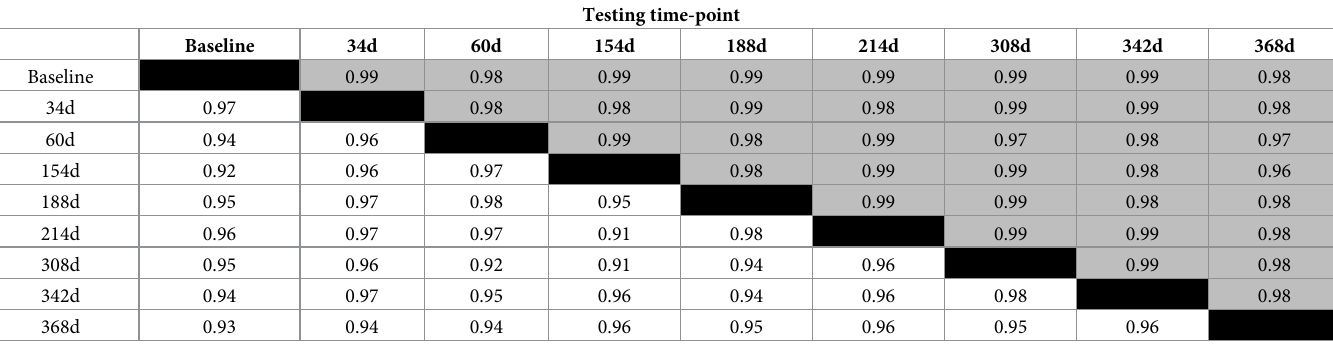
Table 3. Correlation between T 2 at each time-point for the whole intervertebral disc and the nucleus.